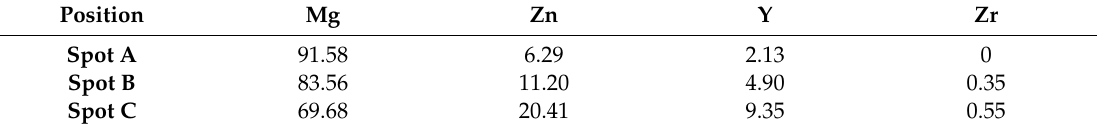
Table 8. Tensile properties of the isothermal forging parts at different temperatures.